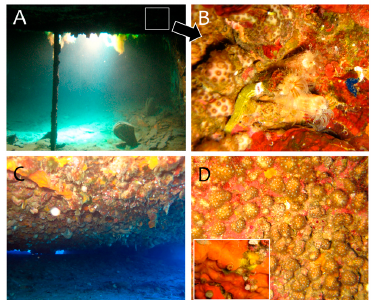
Figure 2. Fouling communities of the studied wrecks. ( A ) Inner chambers with Pinna nobilis in the bottom and coral communities on top; Touba; ( B ) Carbonate build ‐ up of Madracis pharensis and Phyllangia mouchezii corals together with serpulids and calcareous algae; Touba; ( C ) Well developed coral communities and deep scour; Cricket; ( D ) M. pharensis ‐ dominated sections and Caryophyllia inornata individuals partly overgrown by Crambe crambe sponges (insert); Cricket.